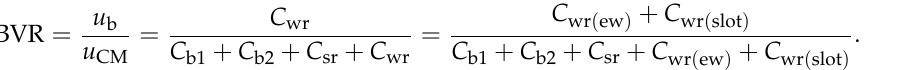
Figure 5. Equivalent diagram of parasitic capacitance with a specification of common-mode voltage u CM and bearing voltage u b .